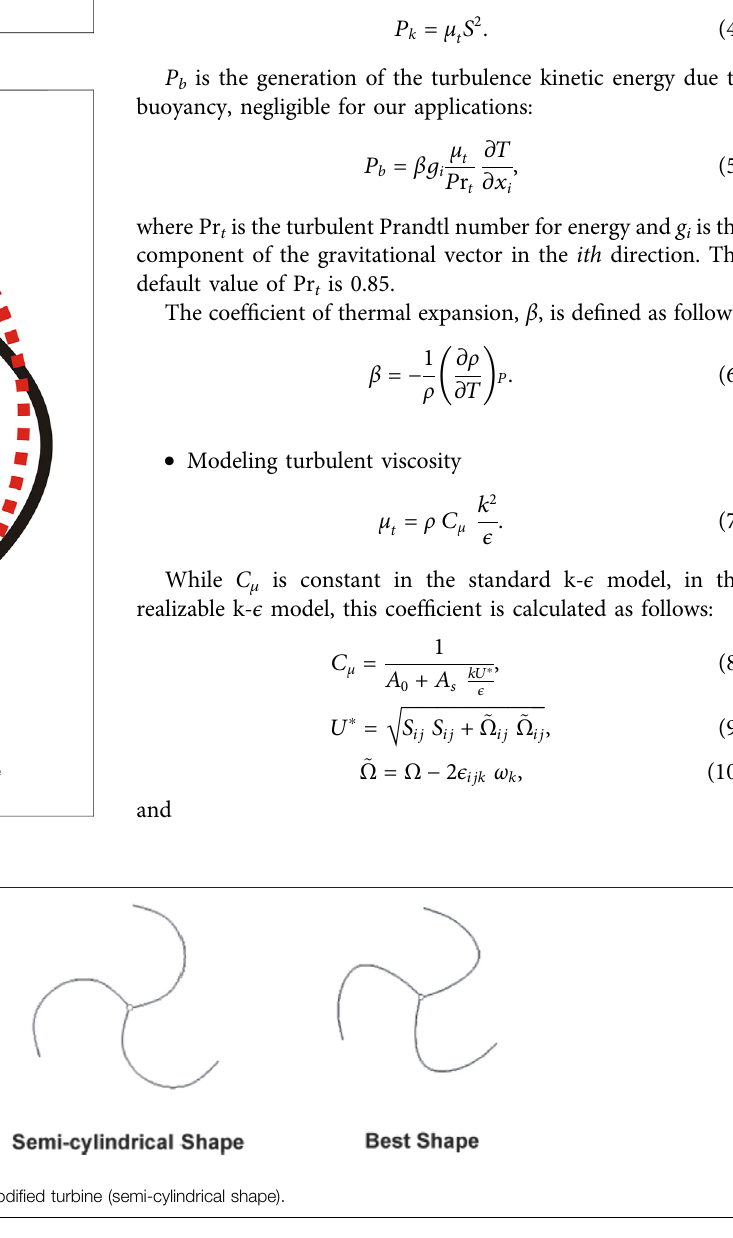
Frontiers in Energy Research |